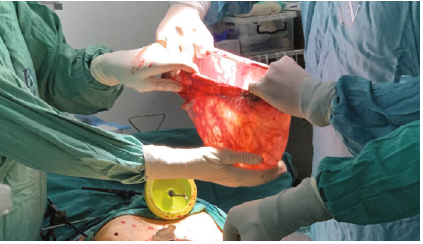
Figure 2: The paratubal cyst sac size noted following excision.